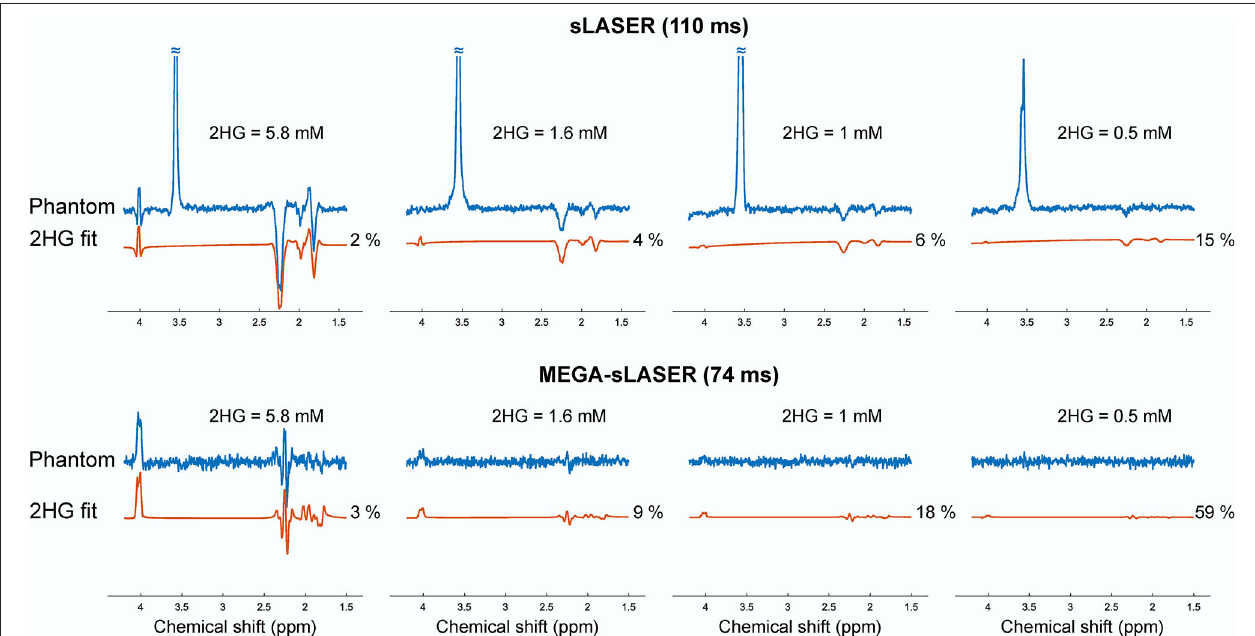
FIGURE 2 | Spectra and the 2HG fits of the four phantoms containing 2HG (5.8, 1.6, 1, and 0.5mM) and glycine (10, 10, 10, and 5mM) from sLASER TE 110ms (top) with MEGA-sLASER TE 74ms (bottom) experiments. The spectra in each row were scaled to standard deviation of the noise.